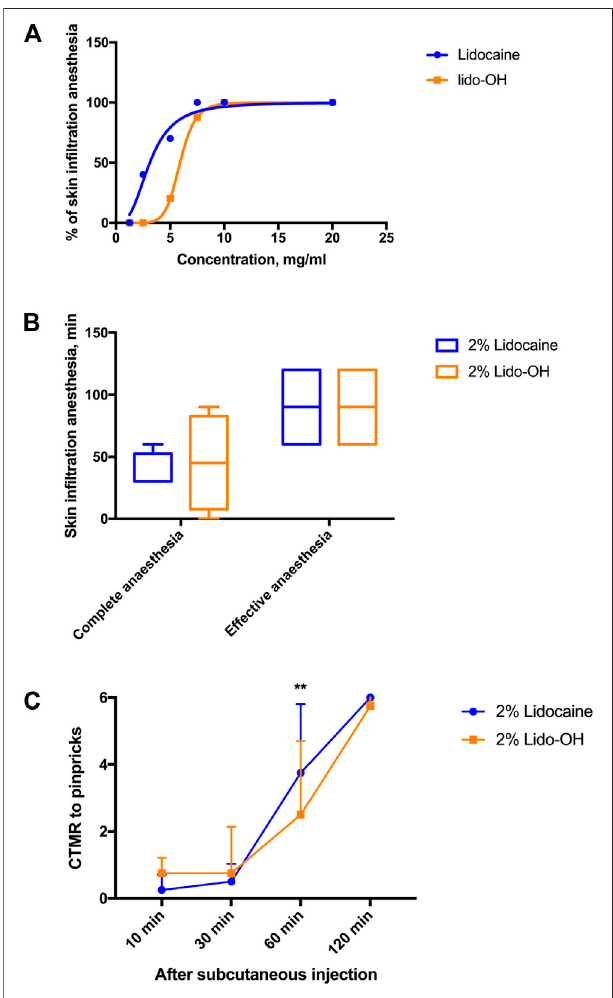
FIGURE 3 | The actions of lido-OH and lidocaine in rat subcutaneous anesthesia(n (cid:1) 8 – 10):theconcentration-effectivenesscurves (A) ;theduration of effective and complete skin in fi ltration anesthesia (B) and the magnitude of anesthesia evaluated by cutaneous trunci muscle re fl ex (CTMR) to pinpricks (C) .**: p (cid:1) 0.0041.Thedottedlinerepresents at eachsamplingtime the total number of pinpricks, which are also the CTMR numbers for